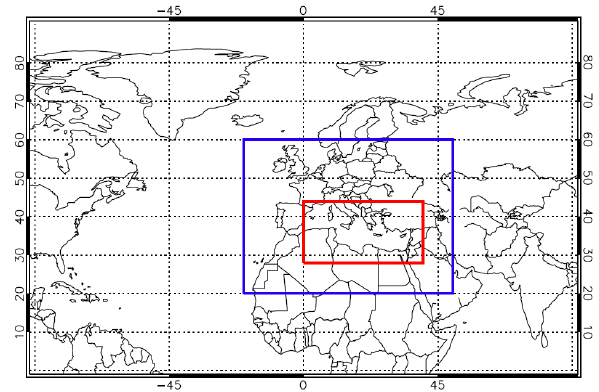
Fig. 4. Map showing the region of interest in this study. The red box depicts what is referred to as the Mediterranean region, and the blue box shows the region referred to as ‘local’ for the purposes of the emissions reductions applied in the model sensitivity experiments.